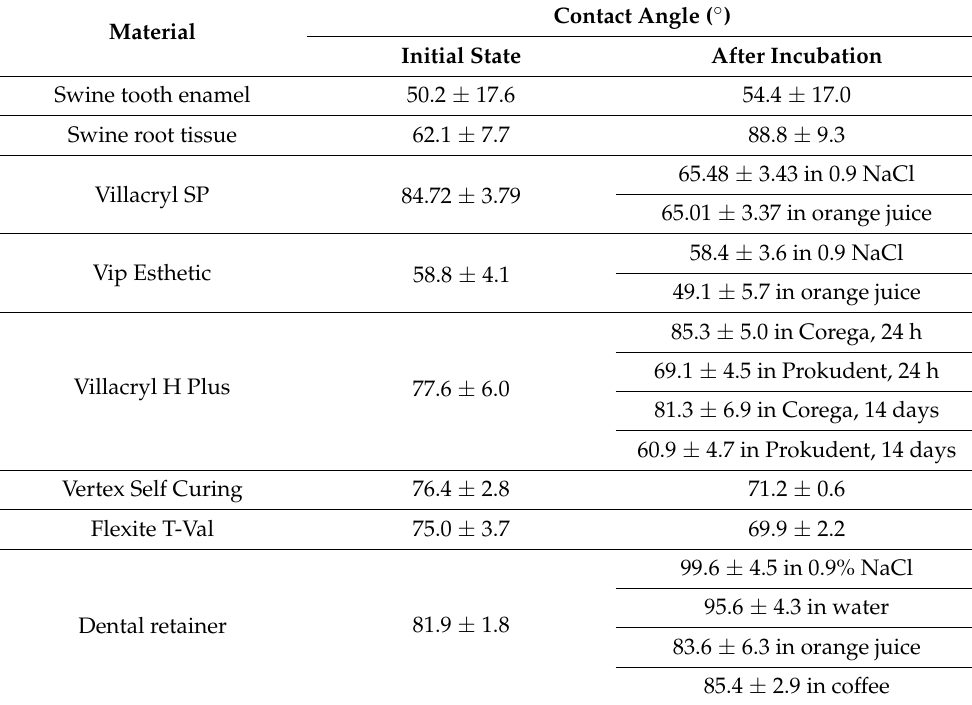
Table 3. Values of the water contact angle for tested